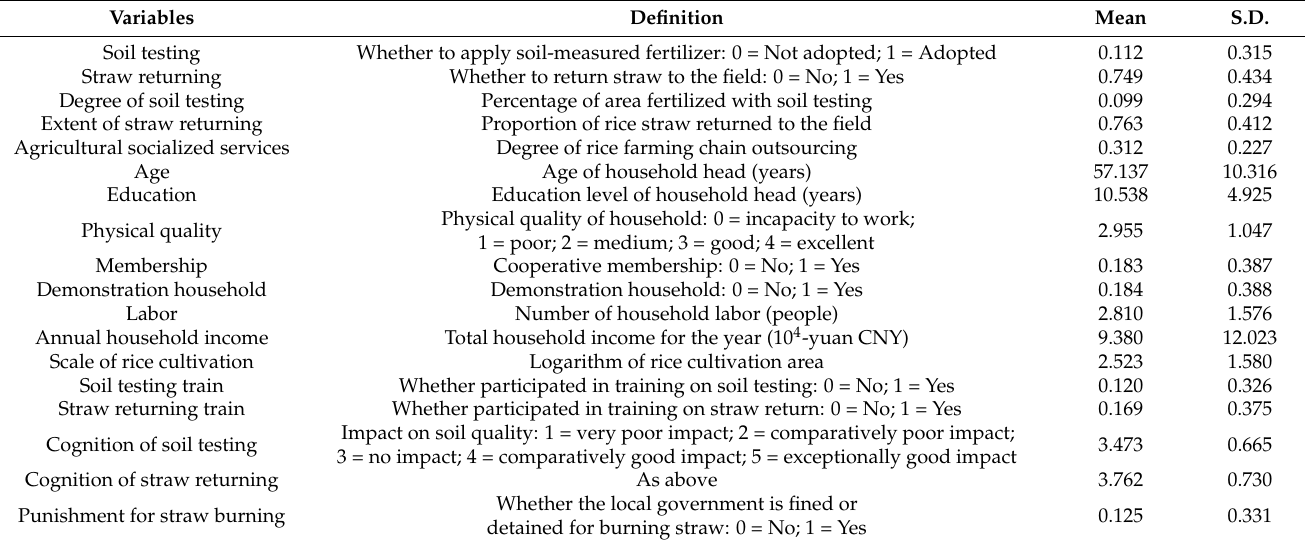
Table 1. Descriptive statistics of